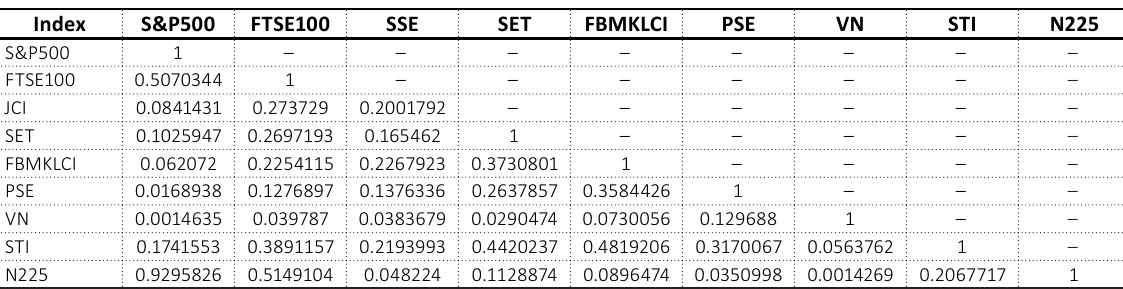
Table 7. Dynamic correlation generalized autoregressive conditional heteroskedasticity (DCC-GARCH(1,1)) estimates (mean of correlations)